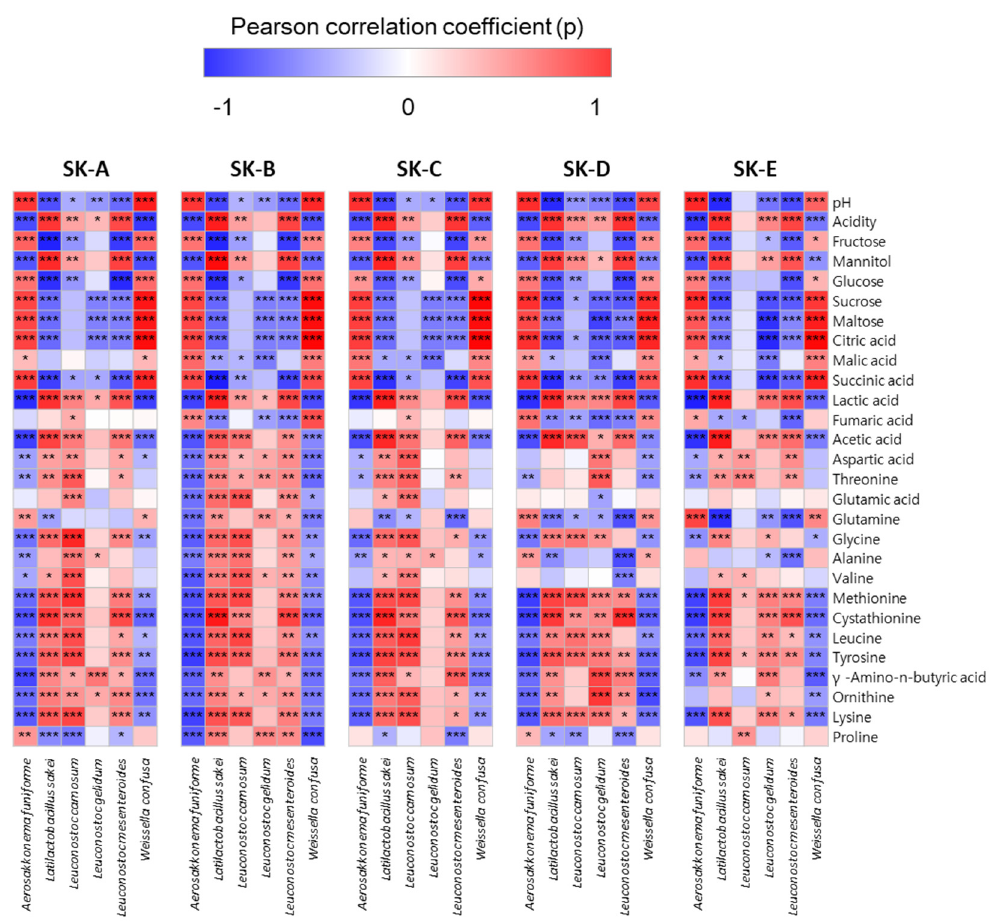
Figure 7. Correlation analysis between successive colonization by lactic acid bacteria and metabolite profiles in kimchi samples fermented at different salinities. The blue and red colors correspond to negative and positive correlation, respectively. The color intensity is proportional to the correlation coefficient. The color bar indicates the corresponding color and correlation coefficient. * p < 0.05, ** p < 0.01, *** p <